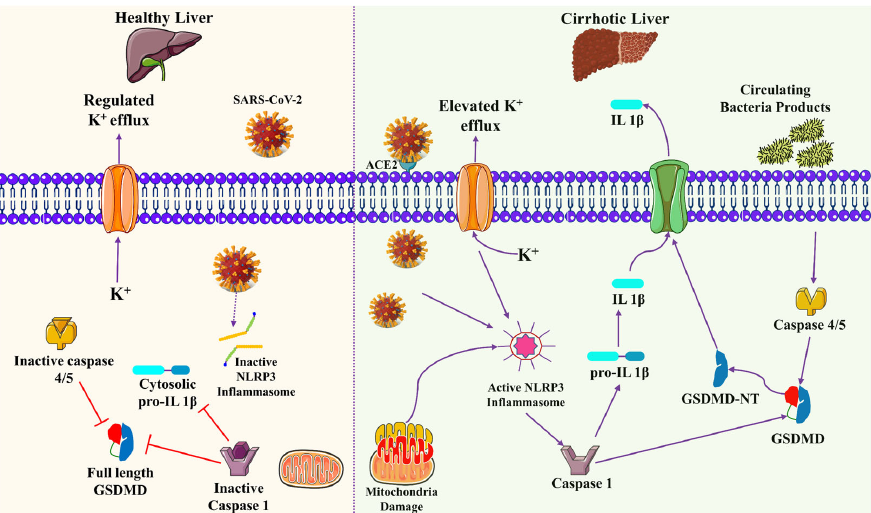
Figure 5. Cirrhosis-related upregulation of hepatocyte inflammasome signaling predisposes increased cell death after SARS-CoV-2 infection. Bacterial substances (such as lipopolysaccharide) bind to and activate caspases-4/5 in cirrhosis (right panel), causing the dimeric protein Gasdermin-D to be cleaved (GSDMD). The N-terminus of GSDMD migrates to the plasma membrane, where it generates holes that allow damage-associated molecular patterns and electrolytes to flow uncontrollably. NLRP3 assembly is also triggered by K + efflux and mitochondrial injury, which activates caspase-1 and results in pro-IL1 processing. Virus proteins attach to the previously synthesized NLRP3, initiating downstream pathways during SARS-Cov-2 infection. In contrast, the absence of the ACE2 receptor in healthy livers (left panel) delays SARS-CoV-2 entry into cells. NLRP3 is present but inactive, preventing proinflammatory caspase activation and processing GSDMD and pro-IL1. This figure is reproduced from Luo et al. [65] (Attribution 4.0 International (CC BY